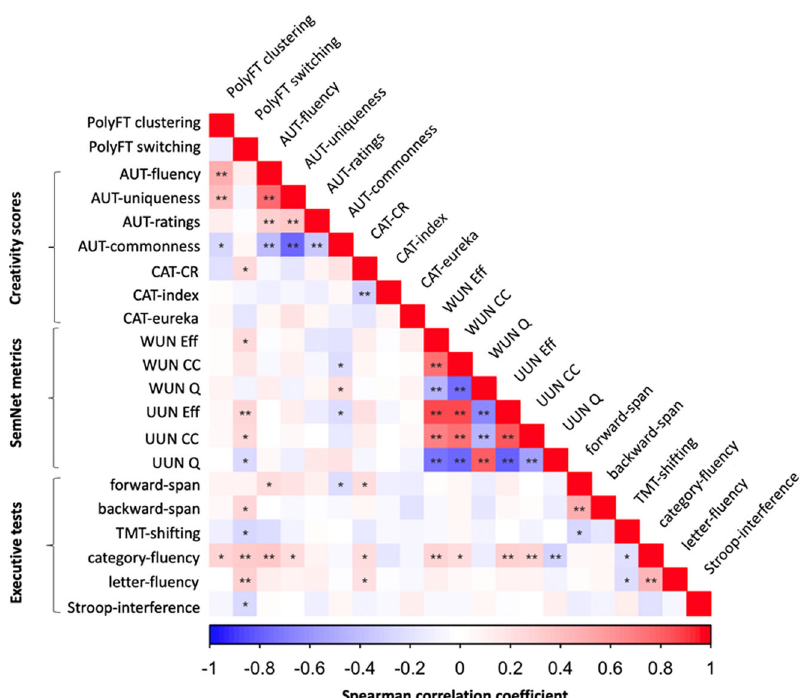
Fig. 1 Correlation matrix of search components with other behavioral measures. Spearman correlations between PolyFT clustering and switching components and SemNet metrics, creativity scores (AUT and CAT tasks) and executive function tests ( n = 86). Cold to hot colors code the Spearman correlation coef fi cient ( r s ). * P < 0.05; ** P < 0.01. All correlations signaled with **( P < 0.01) remained signi fi cant after FDR correction for multiple comparisons.